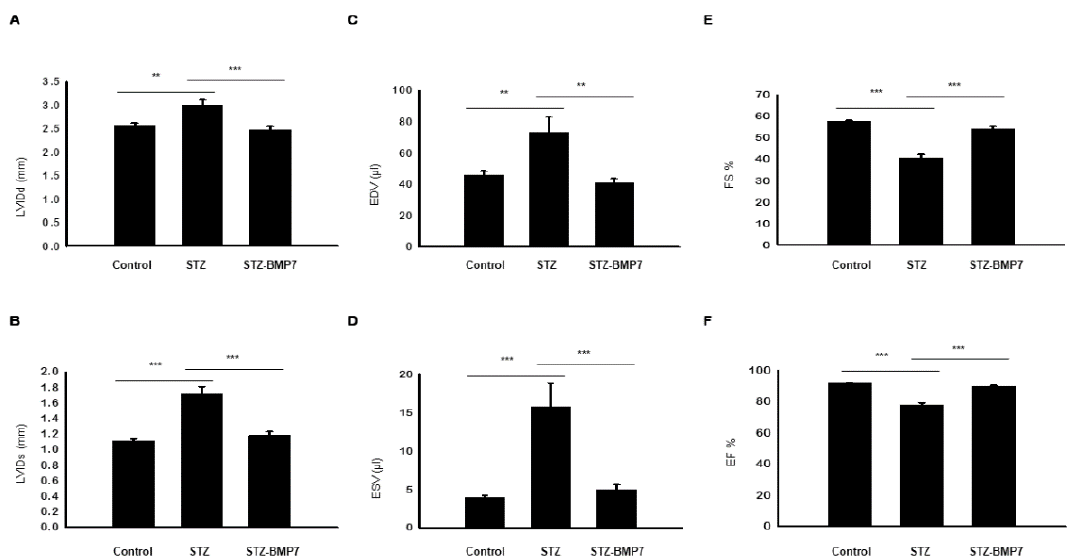
Figure 9. BMP-7 improves overall cardiac function in the diabetic heart. Representative histograms of transthoracic echocardiography data showing the mean ± SEM values for the control, STZ, and STZ-BMP-7 groups: ( A ) left ventricular (LV) internal dimension at end-diastole (LVIDd). ( B ) LV internal dimension at end-systole (LVIDs). ( C ) End-diastolic volume (EDV). ( D ) End-systolic volume (ESV). ( E ) Fractional shortening (FS%). ( F ) Ejection fraction (EF%). Statistical analysis was performed using One-Way ANOVA, which was followed by Tukey test; Error bars = mean ± S.E.M. ** p < 0.01, *** p < 0.001; n = 16/group.